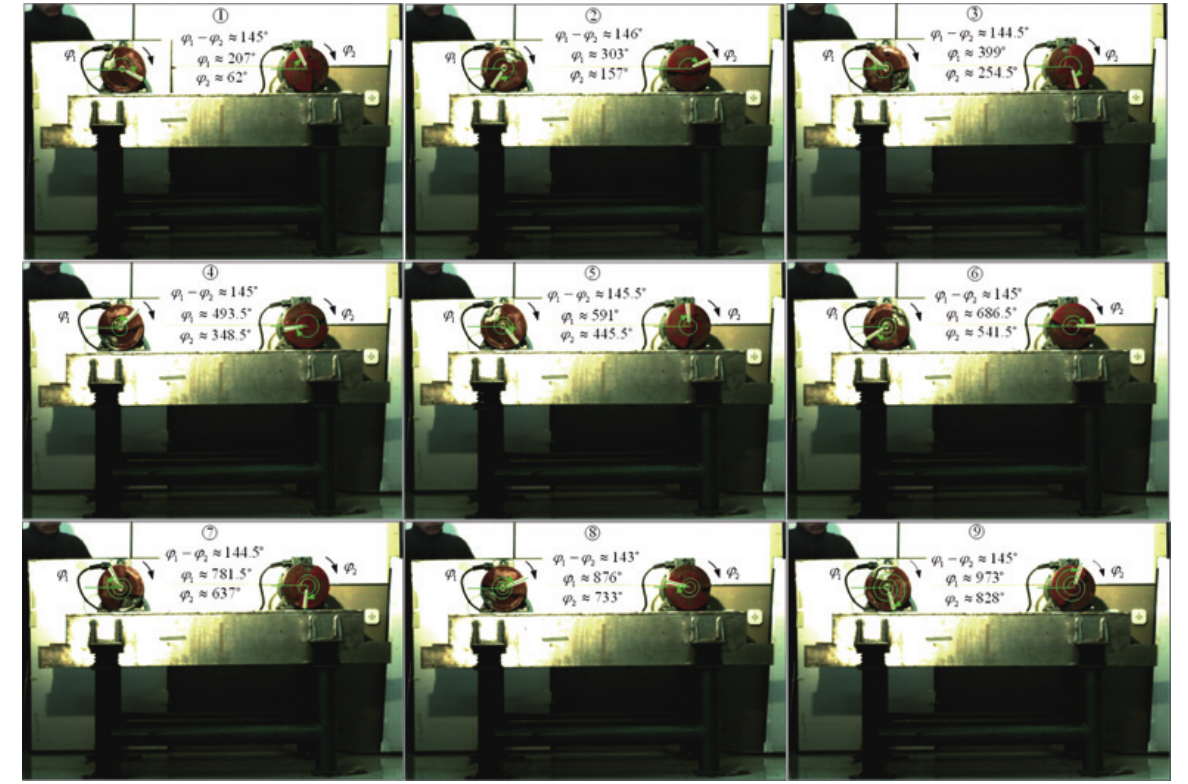
Fig. 9. The phases recorded by high-speed camera before the exciter 2 is cut off ( η = 0 . 5)